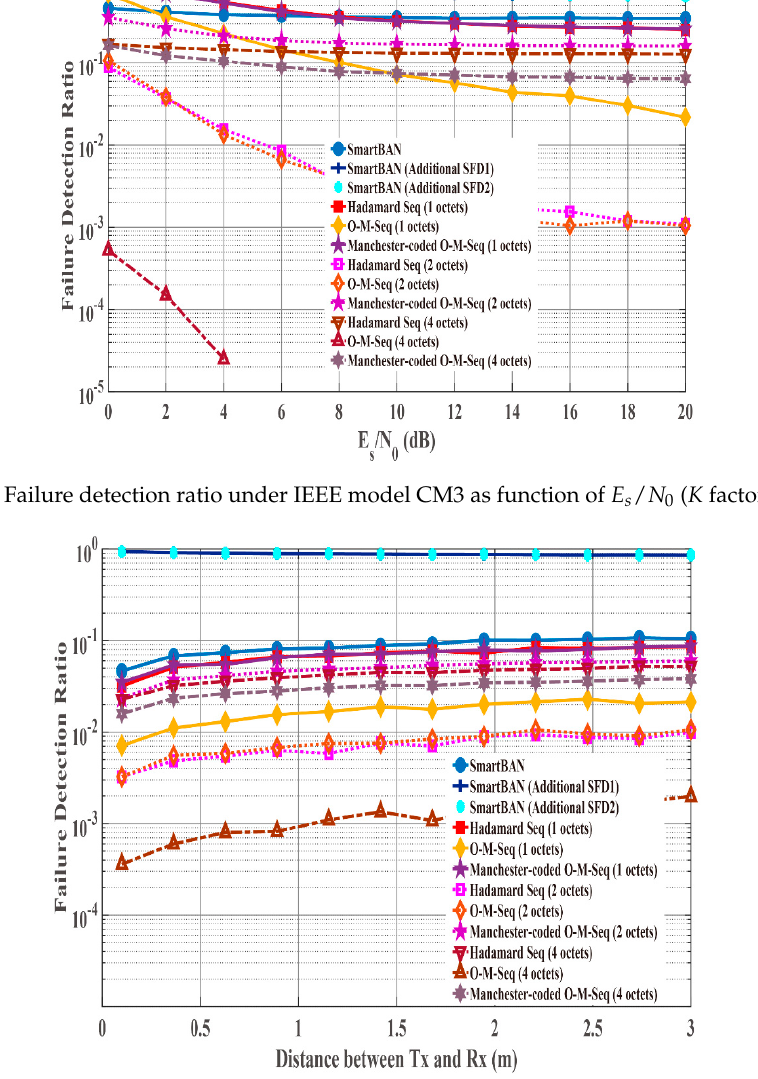
Figure 10. Failure detection ratio under IEEE model CM3 as a function of communication distance.